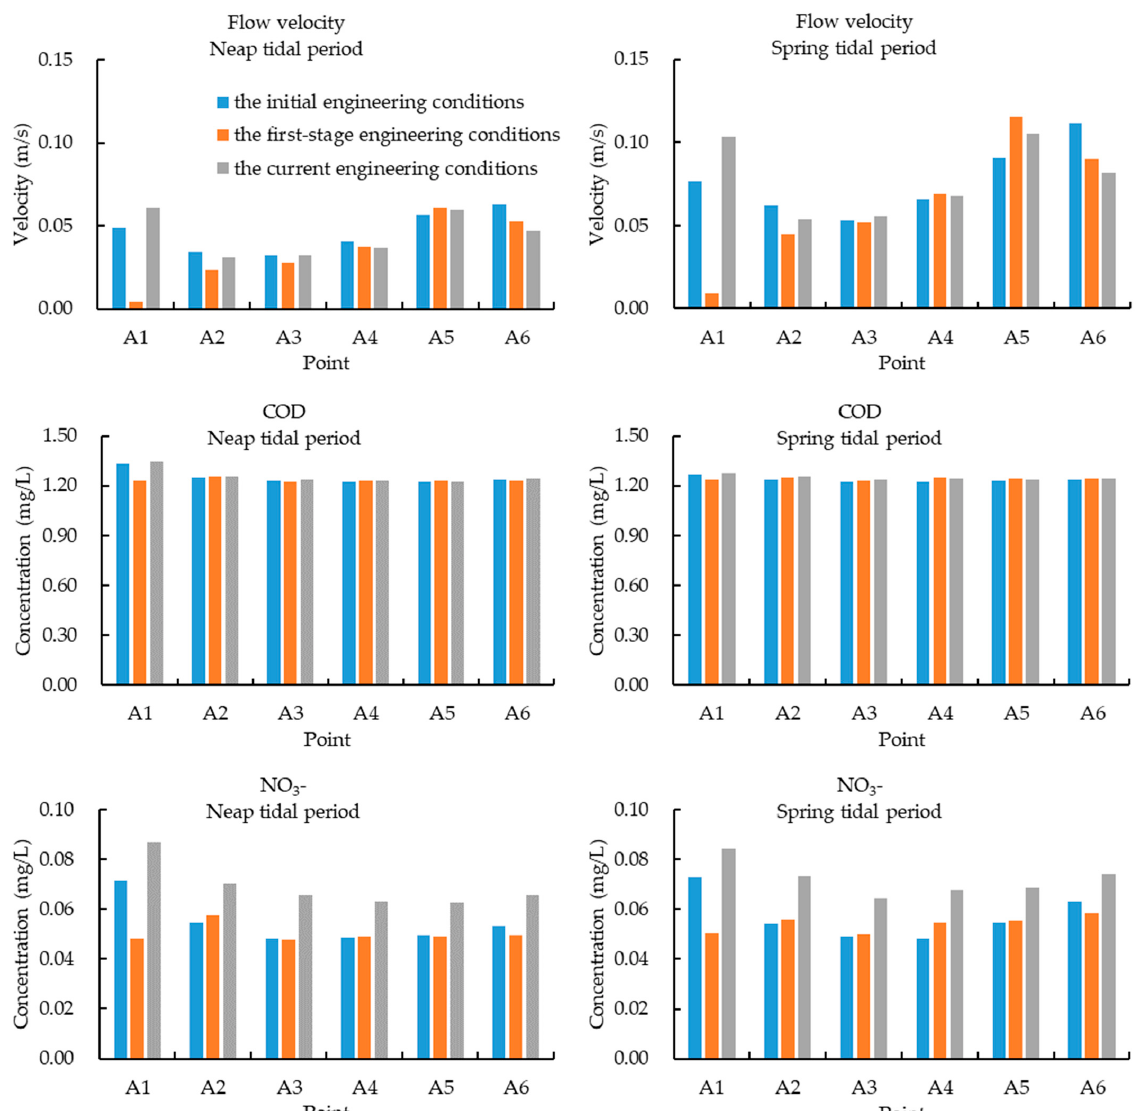
Figure 14. The average flow velocity and the average concentrations of COD and NO 3 − during a spring or neap tidal period at sites of A1 to A6.